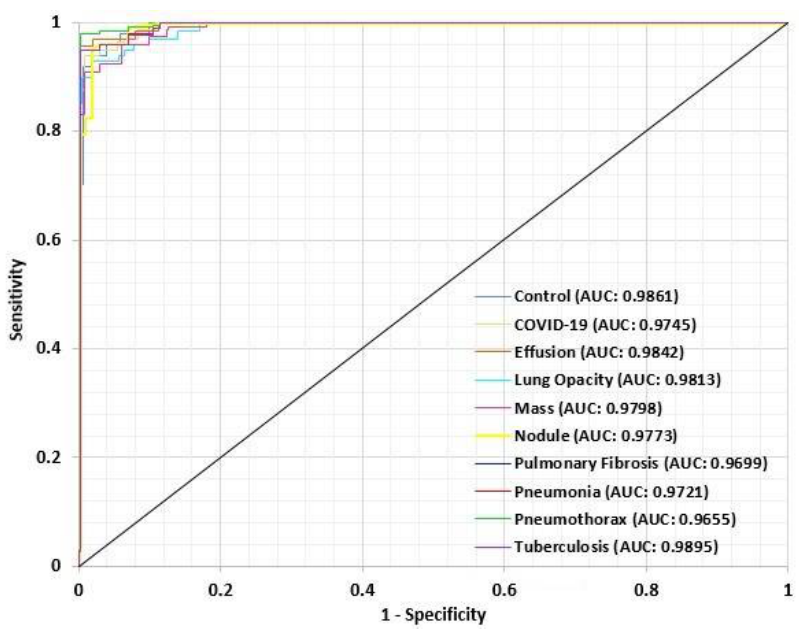
Figure 15. ROC curve for each class of